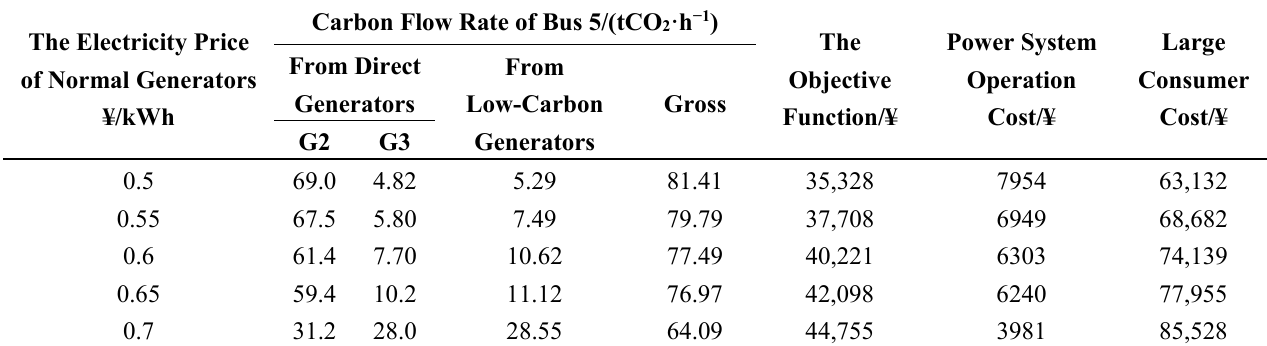
Table 5. Results under the condition of different electricity prices of normal generators. The Electricity Price